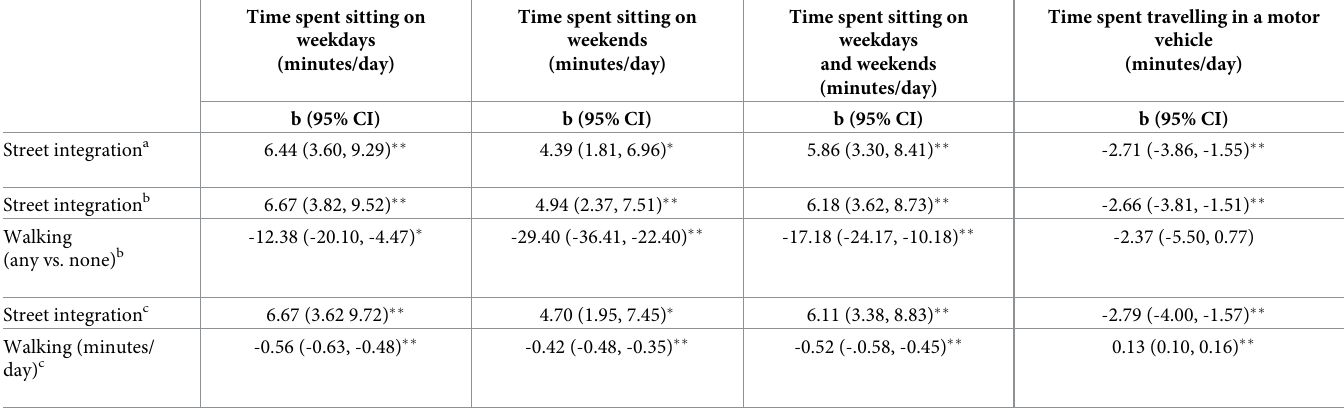
Table 3. Associations between street integration, sedentary behaviour, and walking for participants of Alberta’s Tomorrow Project. Time spent sitting on